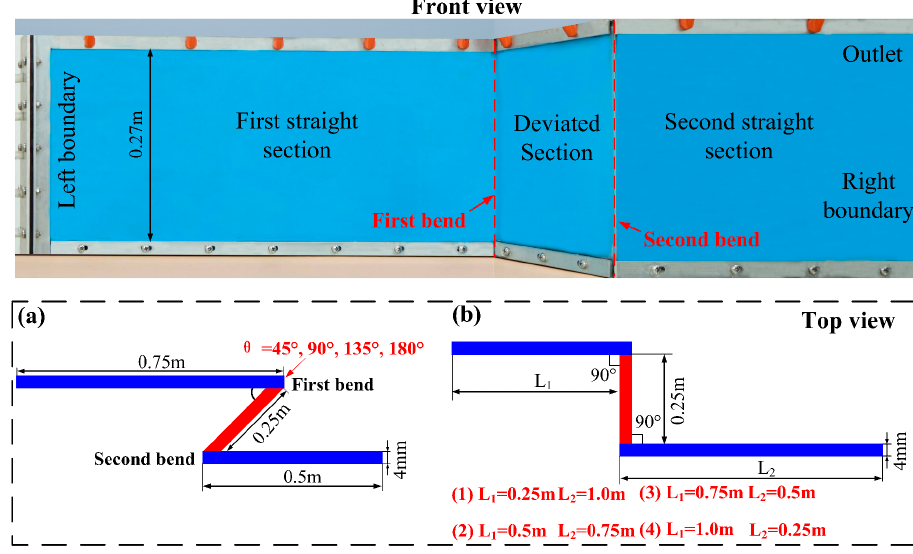
Figure 2. Curving channels at the front view and configurations at the top view.